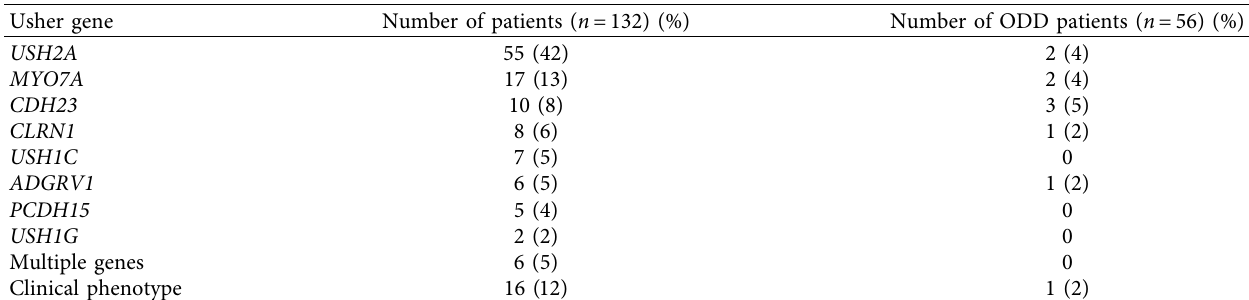
Table 3: Usher cohort genetic testing